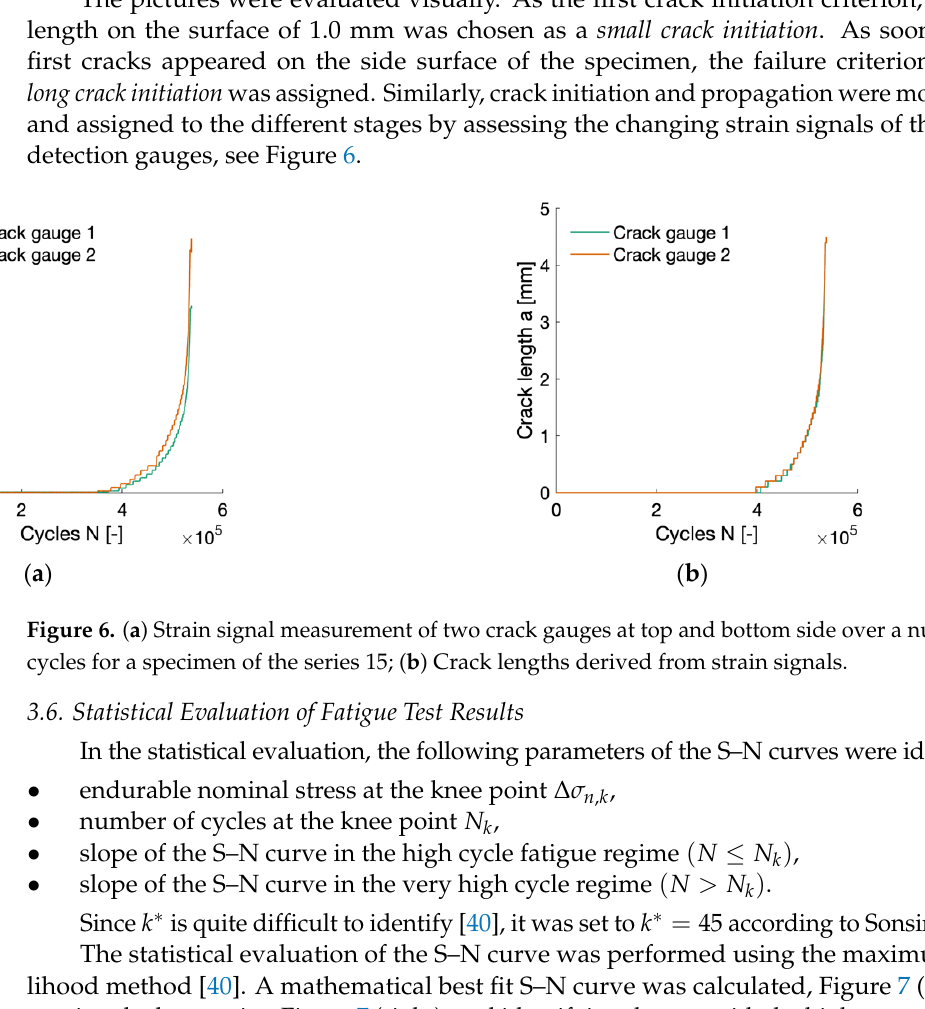
Figure 5. ( a ) Specimen with attached crack gauge after removal of weld overfill and wire erosion of notch into the middle of the weld metal and ( b ) two consecutive pictures of crack detection with photographs (specimen from test series 22).